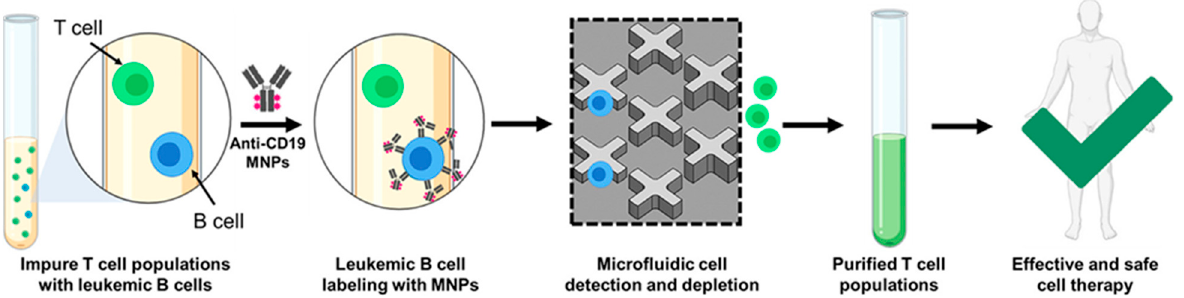
Figure 6. Immunomagnetic purification of CAR T-cells from contaminant leukemic B-cells. Repro- duced with permission [67]. Copyright 2021